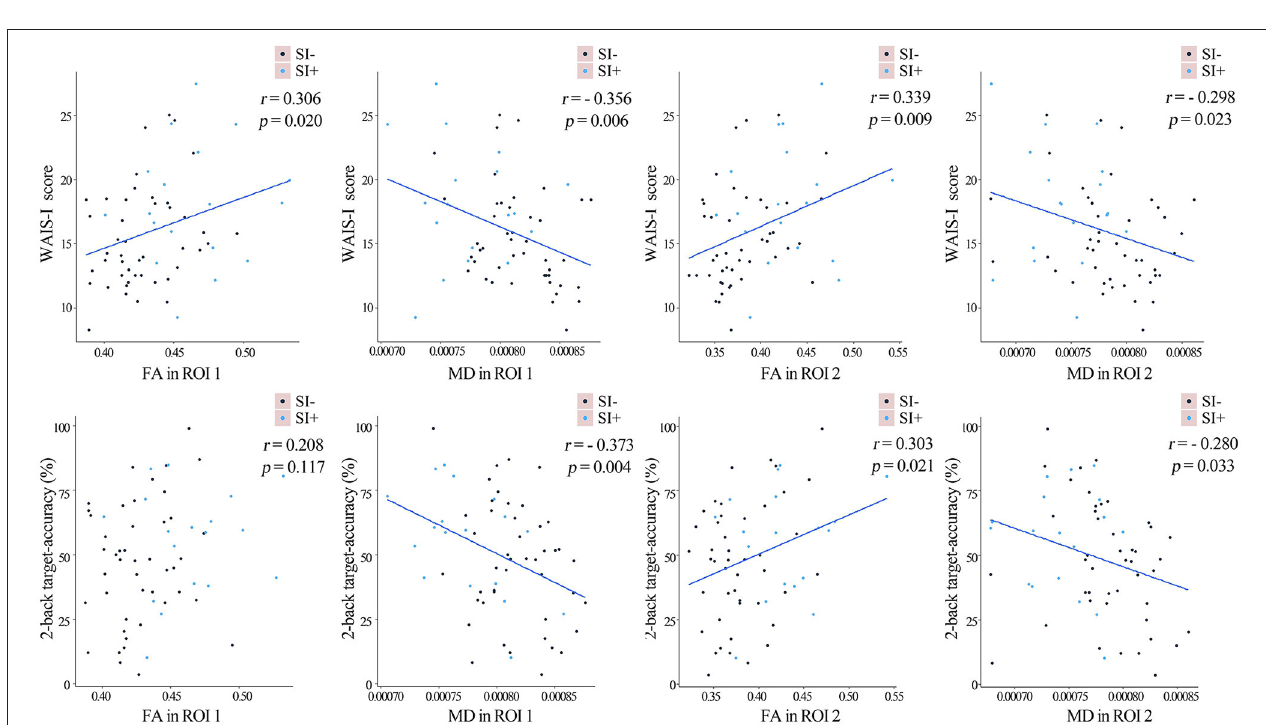
FIGURE 4 | The linear fits representing the partial correlations between the FA/MD values in the two regions of interest (ROI) as described in Figure 2B and cognitive performances in the whole sample of FES patients, after controlling for age, gender, years of education and SAPS/SANS scores. The FES patients with (SI + ) and without (SI–) suicidal ideation were marked in blue and purple separately. FA, fractional anisotropy; MD, mean diffusivity.